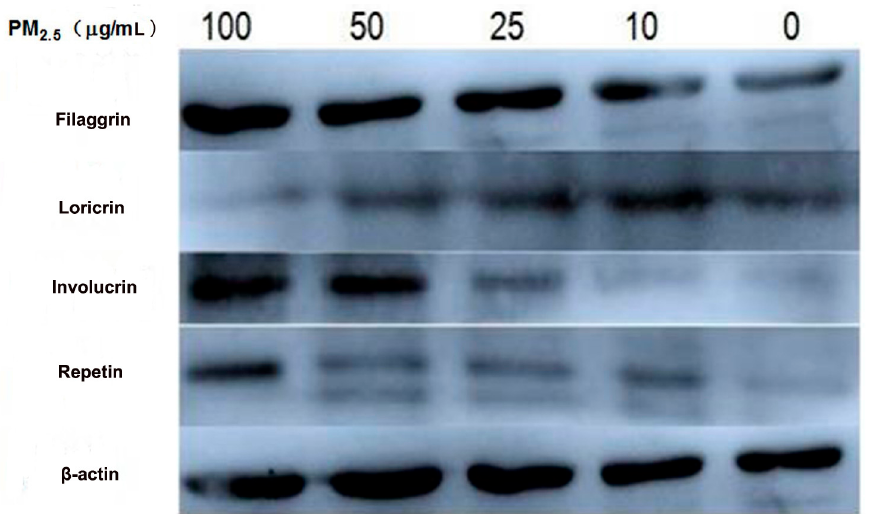
Figure 3. Proteins expression of Repetin ( A ); Filaggrin ( B ); Involucrin ( C ); and Loricrin ( D ) in HaCaT cells after being exposed to different concentrations of PM 2.5 (0, 10, 25, 50, and 100 µ g/mL) for 24 h. ** There were significant differences ( p < 0.01) between the exposed group and the control. ## There were significant differences ( p < 0.01) between the exposure groups. (Analysis of variance (ANOVA) statistics was used to calculate the statistical difference between the exposed group and the control and between the four exposed groups. Each analysis was carried out three times independently).